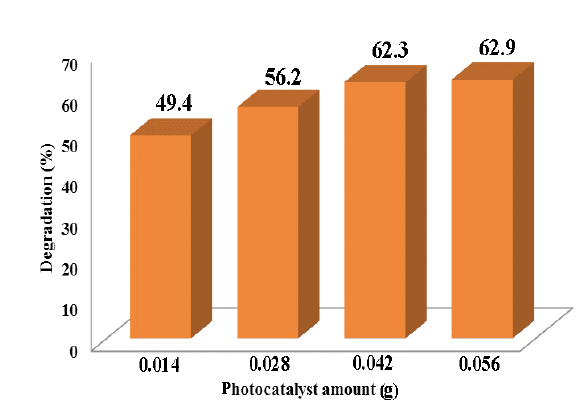
Fig. 4. Photo-catalytic degradation of methyl orange: effect of catalyst